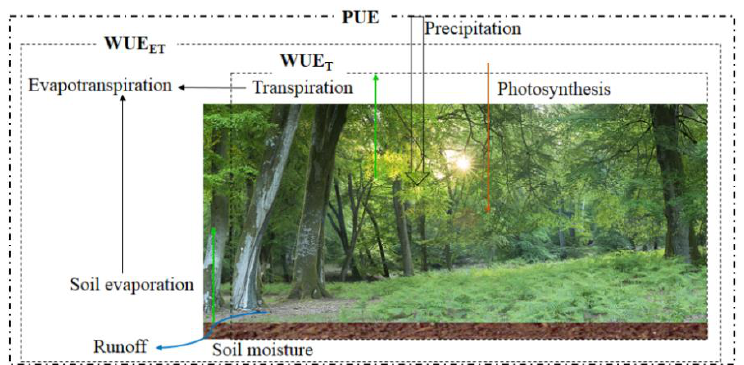
Figure 2. Schematic diagram of the different processes involved in expressing the ecosystem WUE.